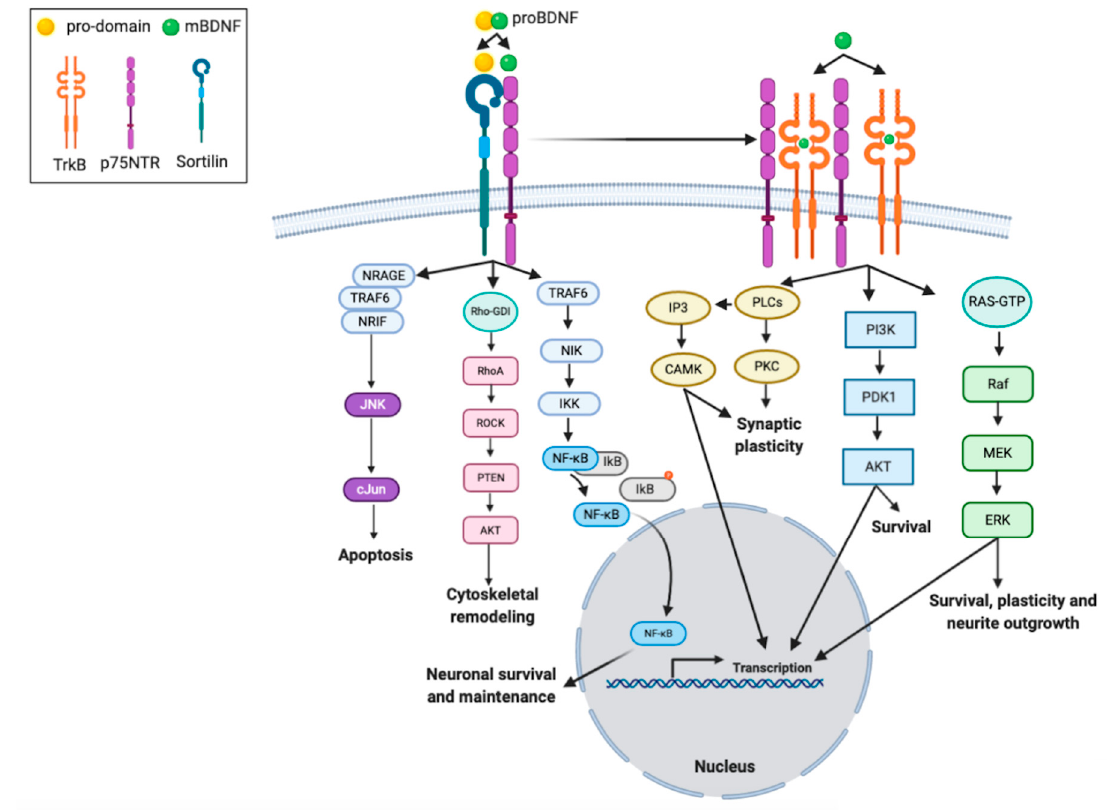
Figure 2. Intracellular signaling cascades activated by interaction of BDNF isoforms with its receptors. proBDNF and mBDNF bind to different receptors, respectively. The mBDNF isoform exhibits highest affinity for the tyrosine kinase B receptor (TrkB) receptor, which when stimulated undergoes homodimerization and autophosphorylation, but also binds the low affinity neurotrophin receptor p75NTR. The interaction between the TrkB receptor and the p75NTR receptor in a complex increases the ligand binding affinity to BDNF. Sortilin is considered a co-receptor for p75NTR. The proBDNF isoform, consisting of two sequences (pro-domain and mature domain), interacts with specific receptors, sortilin and p75NTR, respectively. The binding of proBDNF to a p75NTR/sortilin-complex induces signaling pathways that are specific for proBDNF. The binding of proBDNF in combination with sortilin causes the involvement of neurotrophin receptor-interacting factor (NRIF), tumor necrosis factor receptor-associated factor 6 (TRAF6), and neurotrophin receptor-interacting MAGE homologue (NRAGE) proteins. This pathway activates the JNK-associated pathway that promotes programmed cell death, or the receptor-interacting serine/threonine-protein kinase 2 (RIP2) /TRAF6-mediated pathway is initiated. Multi-subunit I κ B kinase (IKK) phosphorylates (orange dot) the inhibitor of kB (IkB) protein, which results in dissociation of IkB from NF- κ B. The activated nuclear factor kappa B (NF-kB) is then translocated into the nucleus where it binds to specific sequences of DNA and promotes neuronal survival and maintenance. In addition, p75NTR interacts with the Rho family of proteins, whose activation mediates the activity of Rho-associated protein kinase (ROCK), which subsequently leads to activation of the AKT pathway, involved in cytoskeletal remodeling. The mBDNF/TrkB receptor complex triggers signaling pathways associated with activation of phosphatidylinositol 3-kinase (PI3K), phospholipase C gamma (PLC- γ ), and GTP-ases of the Rho family, involved in survival, plasticity and neurite outgrowth, transcription regulation, and synaptic plasticity.